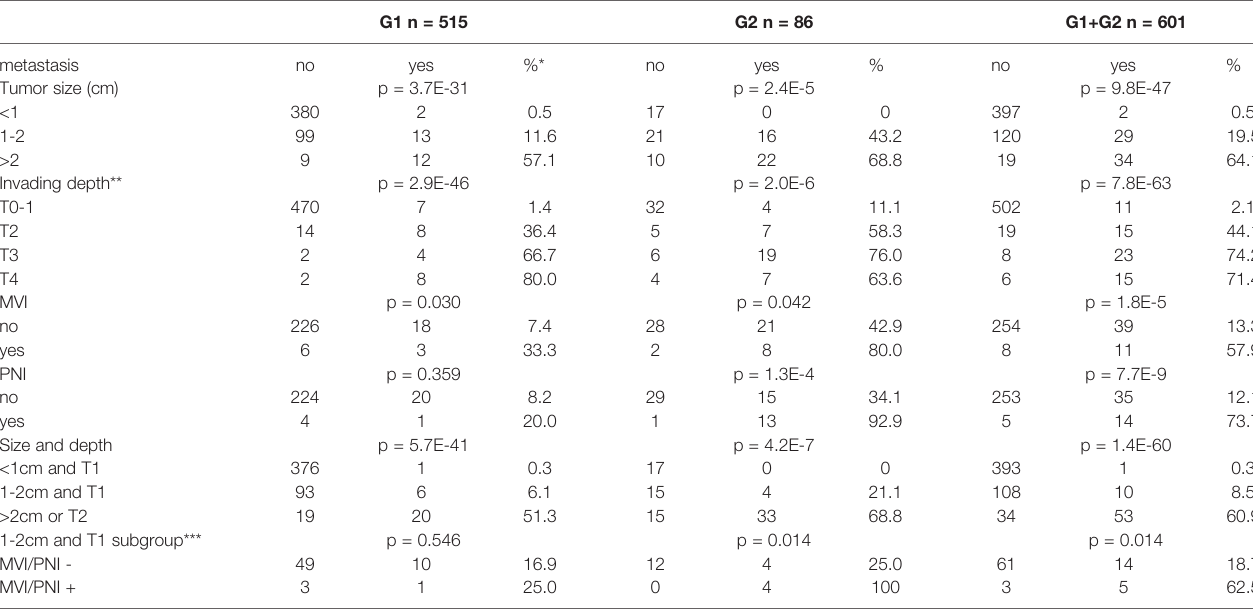
TABLE 3 | Risk factors associated with lymph node metastasis for rectal